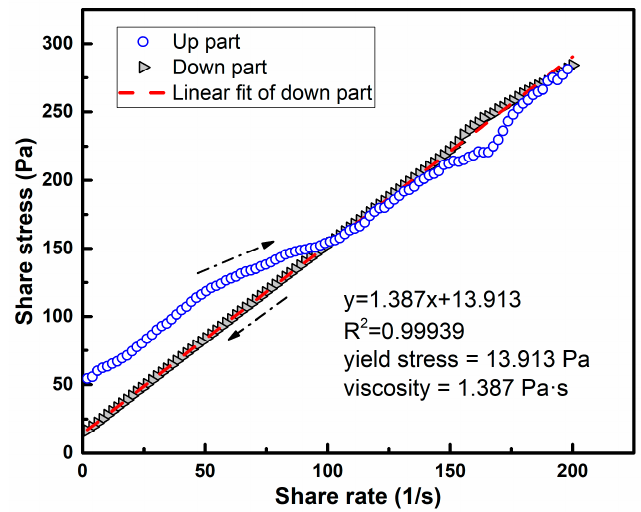
Figure 3. Rheological test results of PMK6.